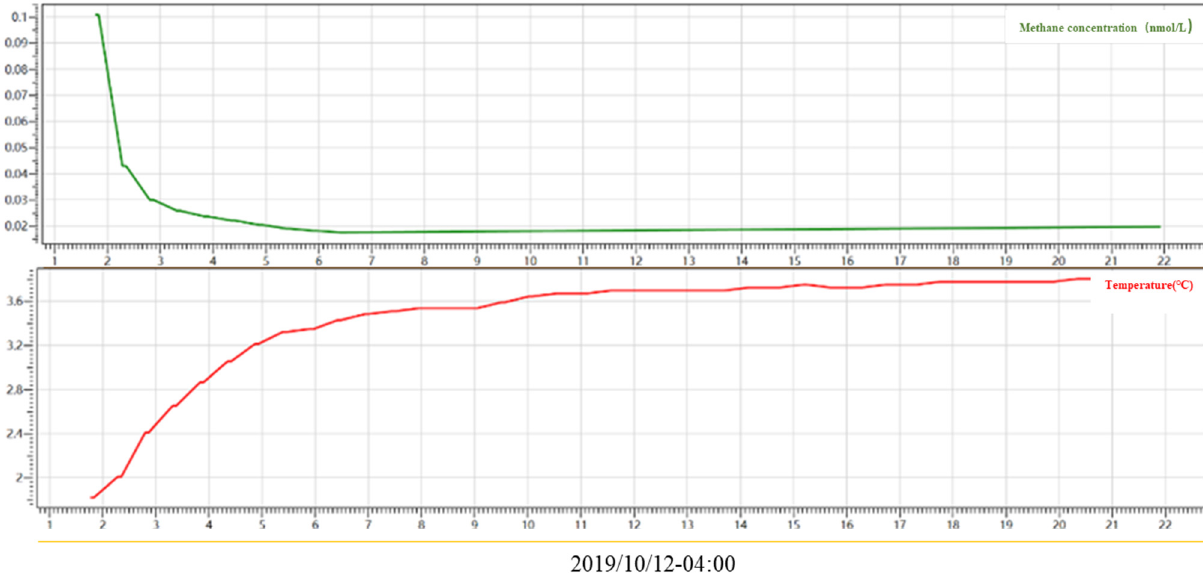
Figure 9. Test data at a water depth of 1250 m (18,260–18,265 sound communication module paired successfully).